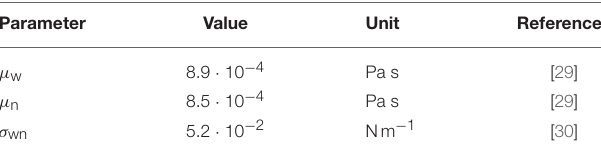
TABLE 1 | Fluid properties corresponding to water (w) and decane (n) at atmospheric pressure and 298K .